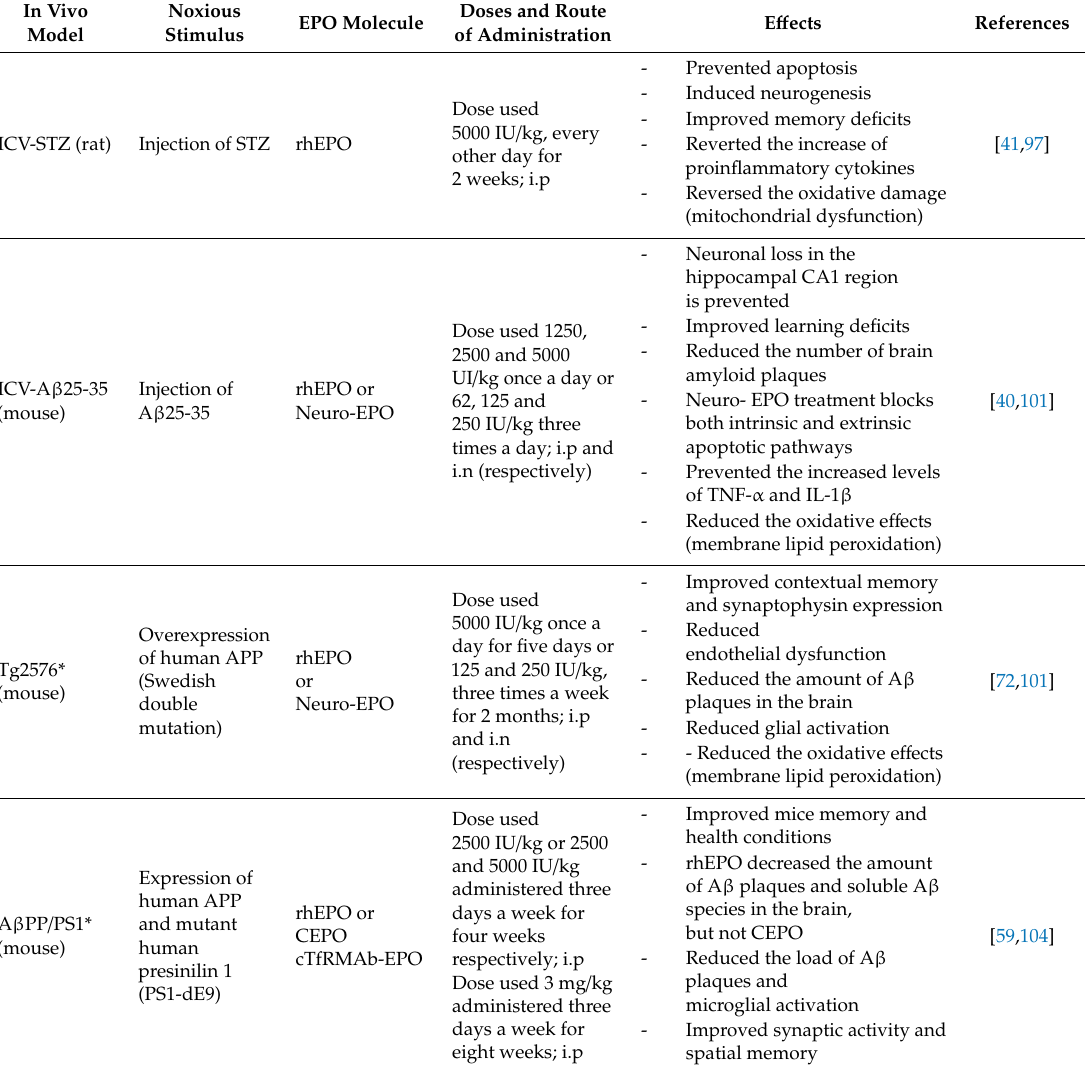
Table3. In vivoADmodels. ICV-STZ;ICV-A β 25-35 = Intracerebroventricularinjectionmodels; Tg2576*; A β PP / PS1* = Transgenic models. rhEPO; EPOL; CEPO; Neuro-EPO and cTfRMAb-EPO =